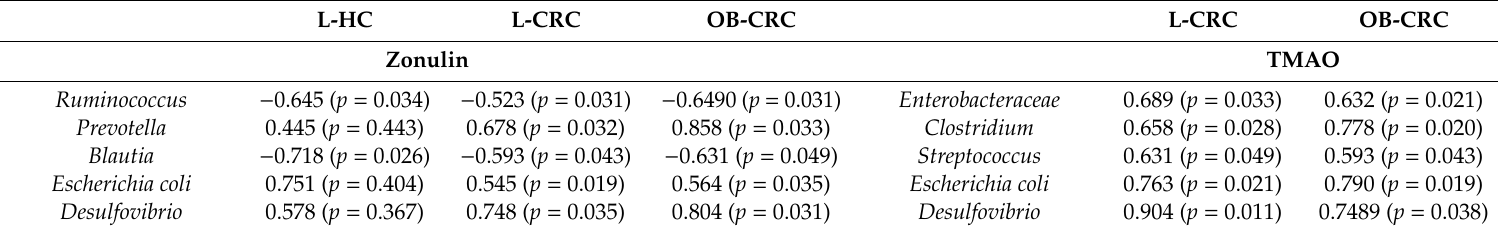
Table 3. Correlations of gut microbiota composition and serum levels of zonulin and TMAO in the study